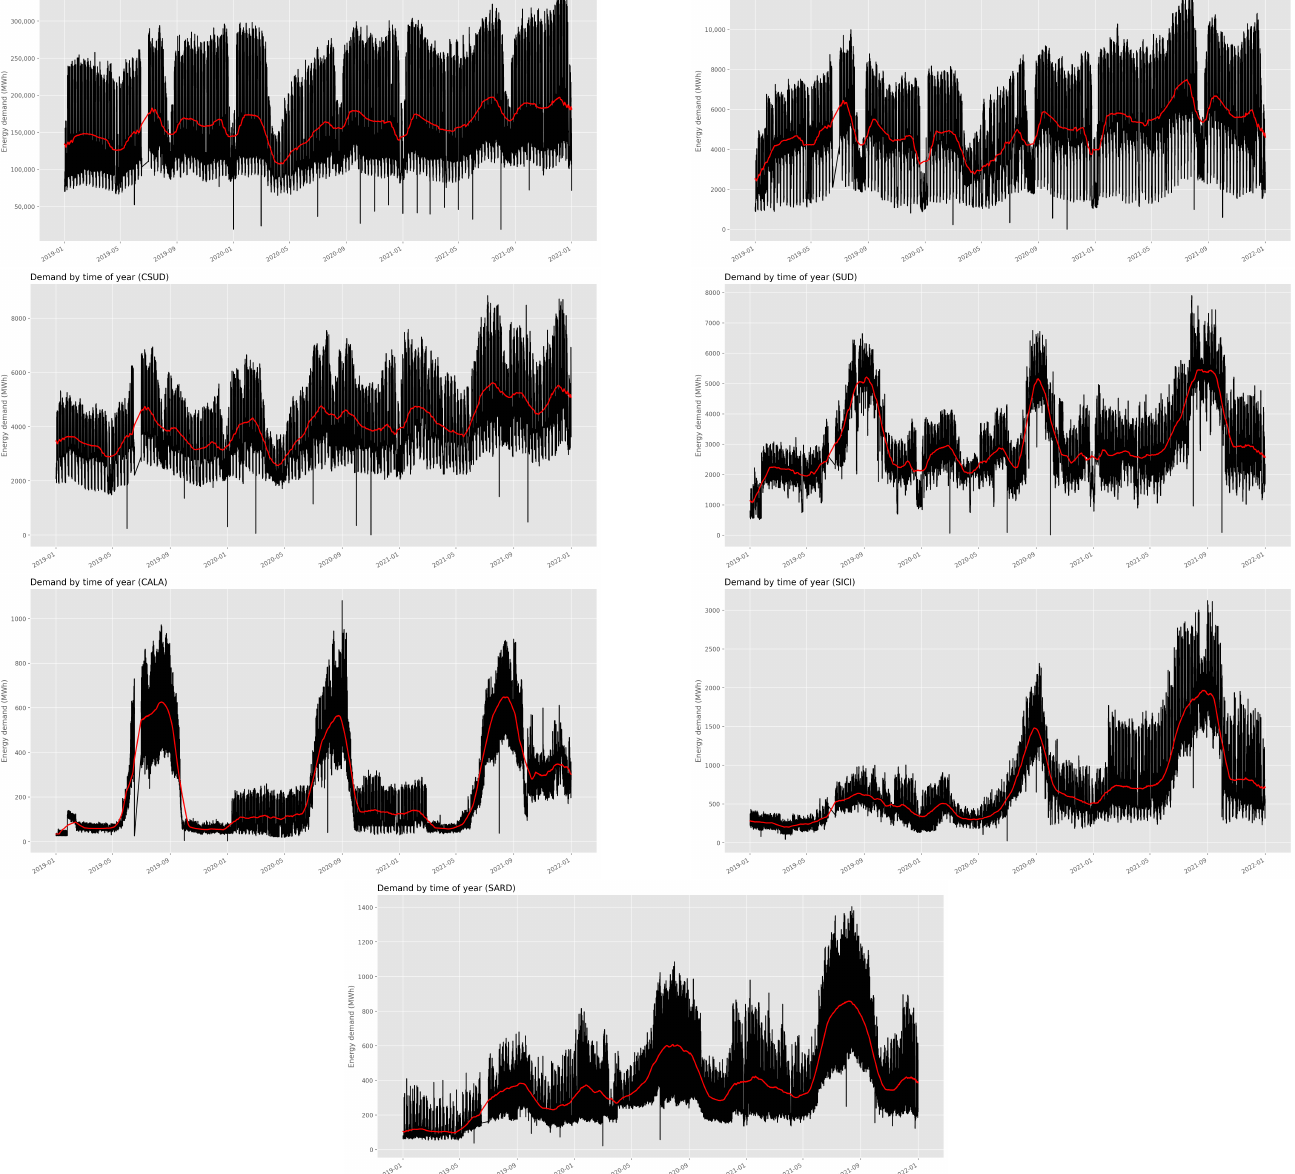
Figure 2. Energy demand plotted against the time of year. The smoothed mean demand is shown as a red